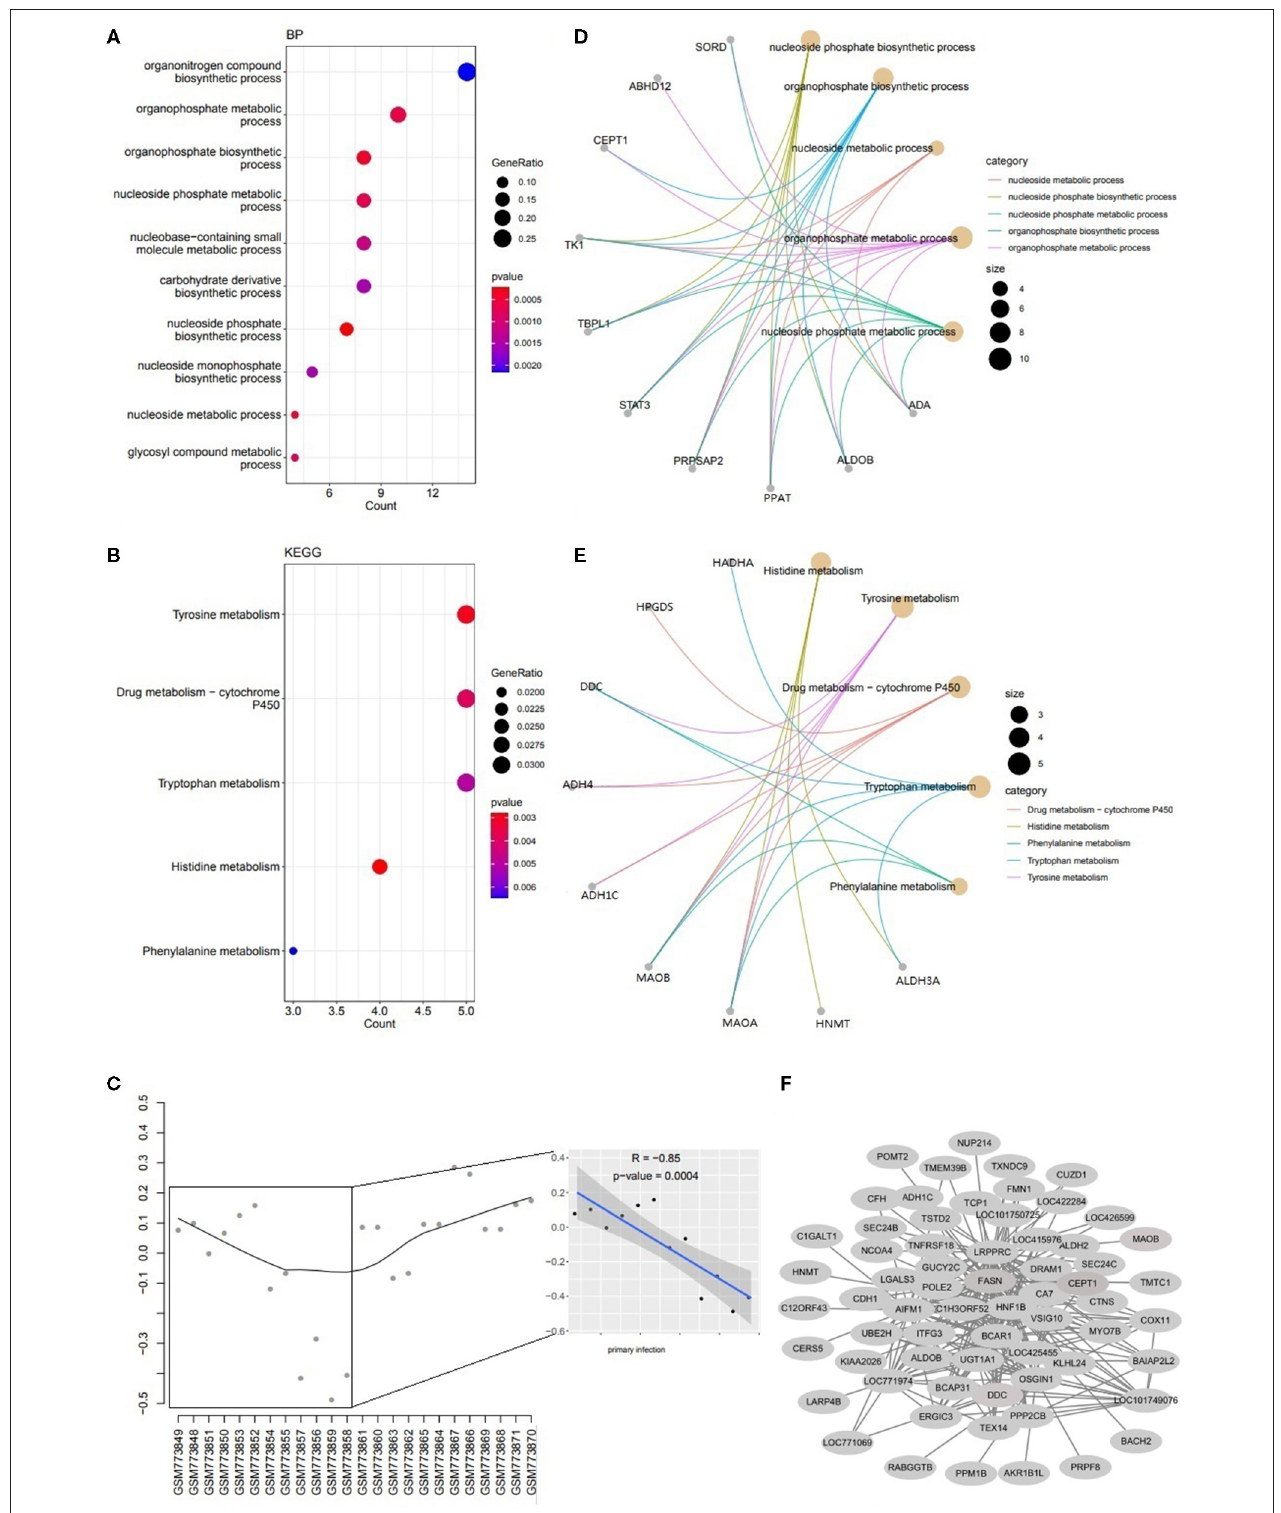
FIGURE 3 | The Functions for genes in yellow module. (A) The dotplot of top 10 BPs. (B) The concept network of top 5 BPs. (C) The dotplot of top 5 KEGG pathways. (D) The concept network of top 5 KEGG pathways. (E) The trajectory curve and linear regression for the eigengene. (F) The coexpression network for module yellow.